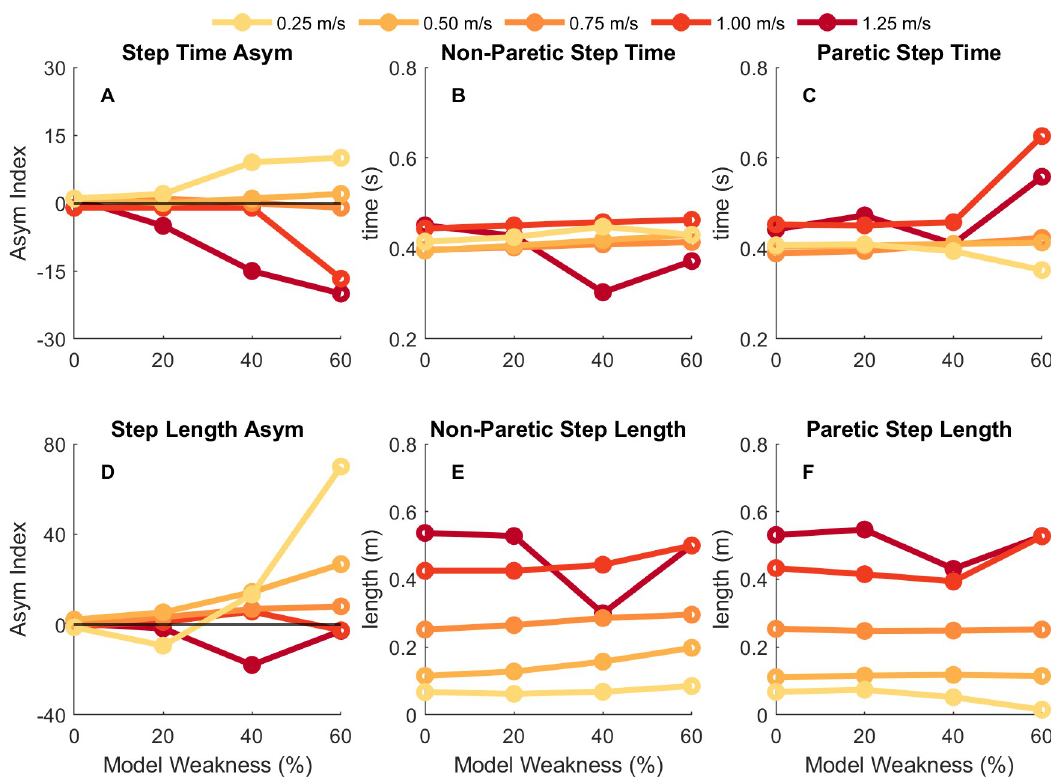
Fig 4. Step time and step length results. Spatiotemporal results for step time (top row) and step length (bottom row) for each condition and each speed. The leftmost column is the step time or step length asymmetry index (A, D), middle column is the non- paretic (right) step time or step length value (B, E), and rightmost column is the paretic (left) step time or step length value (C, F). Darker, red colors depict results for faster speeds while lighter, yellow colors depict results for slower speeds. Positive asymmetry indices indicate that the non-paretic value is greater than the paretic value, whereas negative asymmetry indices indicate that the paretic value is greater than the non-paretic value.